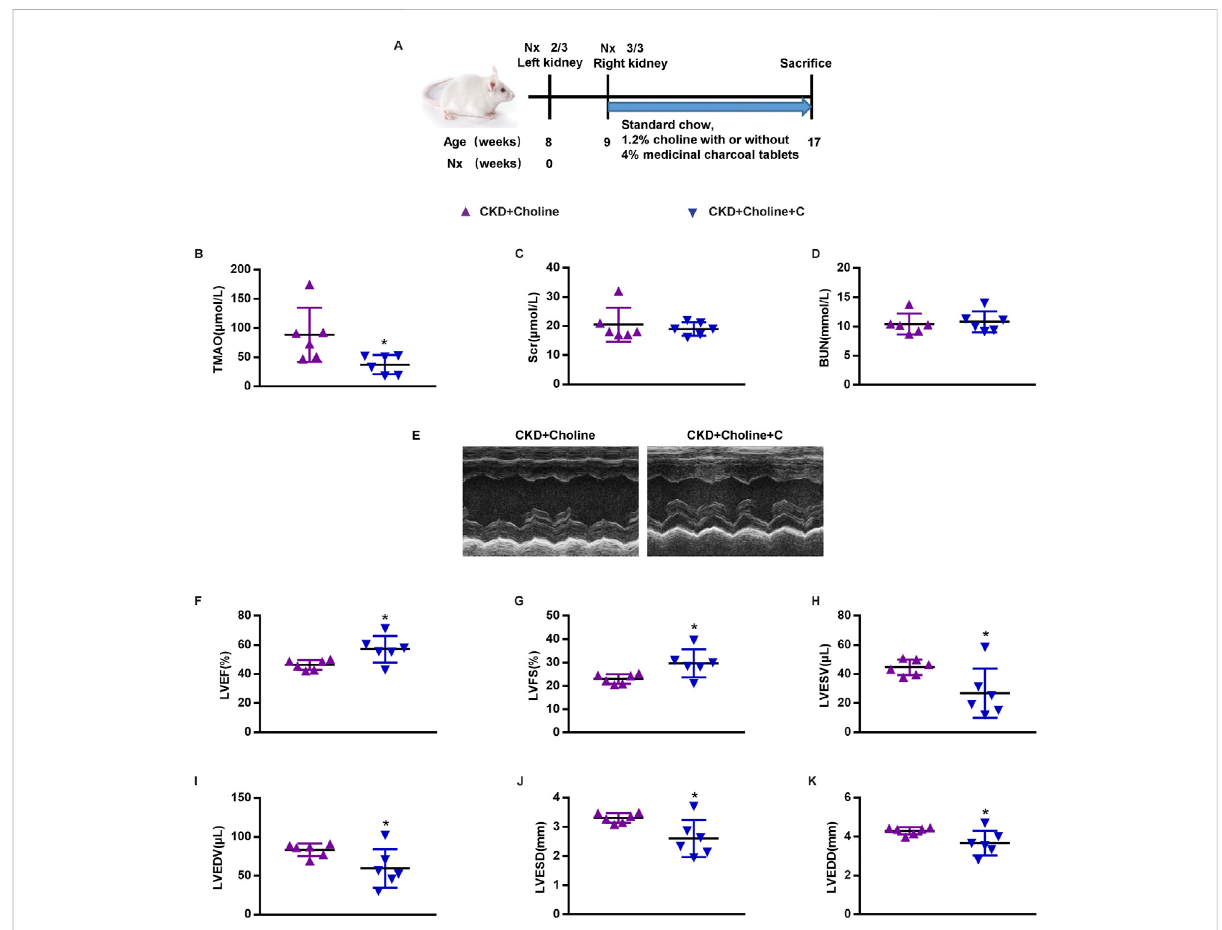
FIGURE 3 Medicinal charcoal tablets reduces TMAO, and improves cardiac dilation and dysfunction in 5/6Nx mice on a high-choline diet. (A) Schematic design of CKD animal model (5/6 Nx) and treatments. (B) The serum level of TMAO. (C) The serum level of Scr. (D) The serum level of BUN.